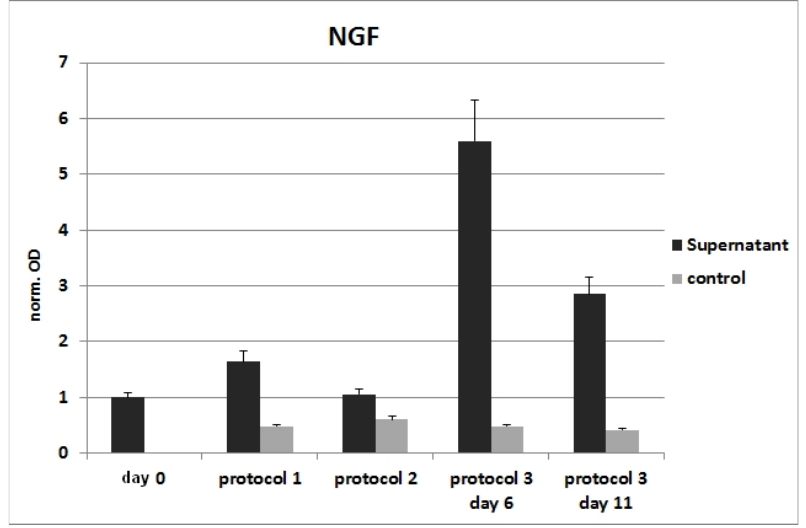
Figure 4. ELISA with supernatants from neuronally differentiated ADSCs. Expression of NGF is especially upregulated after differentiation with Protocol 3. The obtained values were not normalized to the total cell number. 3.5. RT-PCR after Differentiation of ASCs on Coated Surfaces Selected marker genes were tested for differential regulation, in which their respec- tive differentiation protocols were conducted on the coated surfaces. The results on the coated surfaces were calibrated to the basic protocol, in which the respective upregulation was observed. Compared with the basic Protocol 1, the GFAP upregulation was not im- paired on the collagen surface, and it even increased on the fibronectin surface. However, on laminin and poly-L-ornithine, the GFAP upregulation was slightly impaired (Figure 5). The observed upregulation of MBP and P0 after differentiation with Protocol 2 was reduced on most of the coated surfaces. Both the collagen and fibronectin coatings led to a slight decrease in the MBP upregulation and P0 upregulation. The laminin coating caused a minor decrease in P0 upregulation, and a major decrease in MBP upregulation. The upregulations of both MBP and P0 were nearly unaffected by the poly-L-lysine coat- ing, whereas the poly-L-ornithine coating led to a major decrease in the MBP upregula- tion, and the expression of P0 was unaffected (Figure 5). The upregulation of NGF after differentiation with Protocol 3 was not impaired on any of the surfaces. On the laminin, however, a significant increase was observed (Figure 5).